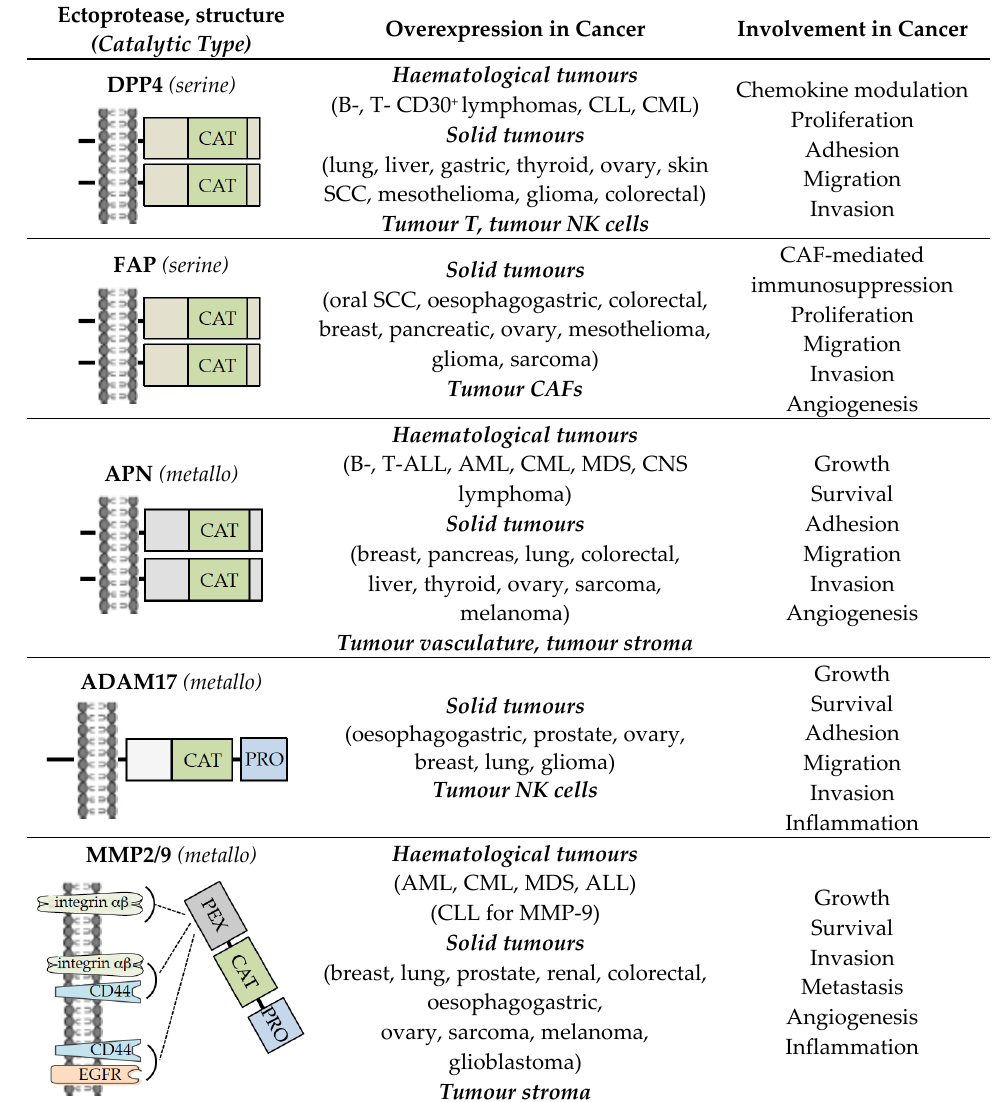
Figure 1. Structure, overexpression, and involvement of ectoproteases in cancer. The structures are simplified to show the domains of ectoproteases discussed in the text. DPP4, FAP, and APN are dimers of two noncovalently associated monomers. ALL, acute lymphoblastic leukaemia; AML, acute myeloid leukaemia; CAF, cancer-associated fibroblast; CAT, catalytic site; CLL, chronic lymphocytic leukaemia; CML, chronic myeloid leukaemia; CNS, central nervous system; EGFR, epidermal growth factor receptor; MDS, myelodysplastic syndrome; PEX, hemopexin domain; PRO, prodomain; SCC, squamous cell carcinoma. The catalytic type is mentioned according to The MEROPS database of proteolytic enzymes: https://www.ebi.ac.uk/merops/index.shtml (accessed on 16 December 2016).